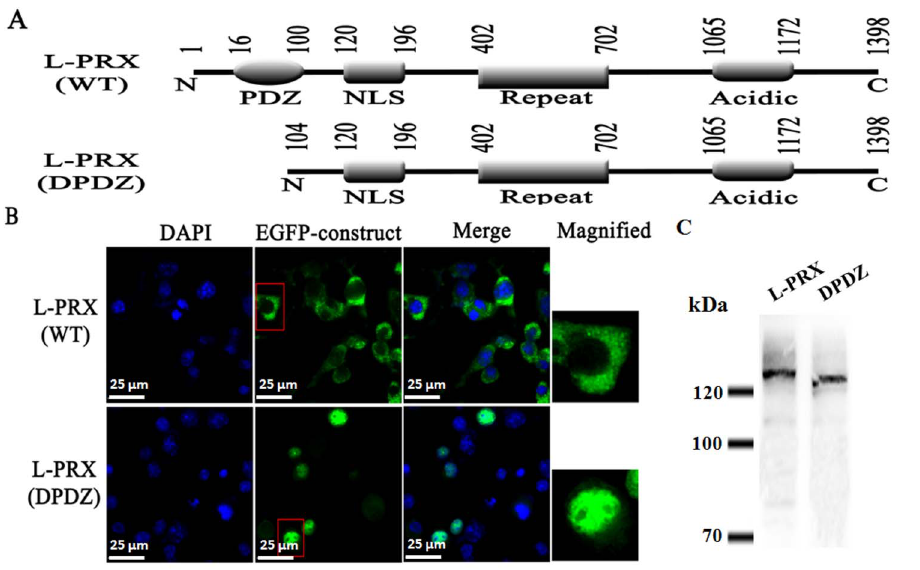
Figure 1. PDZ is necessary to accomplish an efficient nuclear export of L-PRX. (A) Structures of L-PRX and its PDZ-deleted mutants (DPDZ- L-PRX). Amino acid residues flanking each domain are numbered on top of the diagram. (B) Subcellular localization of EGFP-tagged L-PRX and its PDZ-deleted mutant (DPDZ-L-PRX). RSC96 cells were transfected with the plasmids encoding EGFP-tagged full-length L-PRX and its DPDZ-L-PRX. Scale bar=25 m m. (C) GFP fusion constructs detected by Western blotting to ensure that the visualized proteins are not free GFP, or GFP fused to a truncated protein.